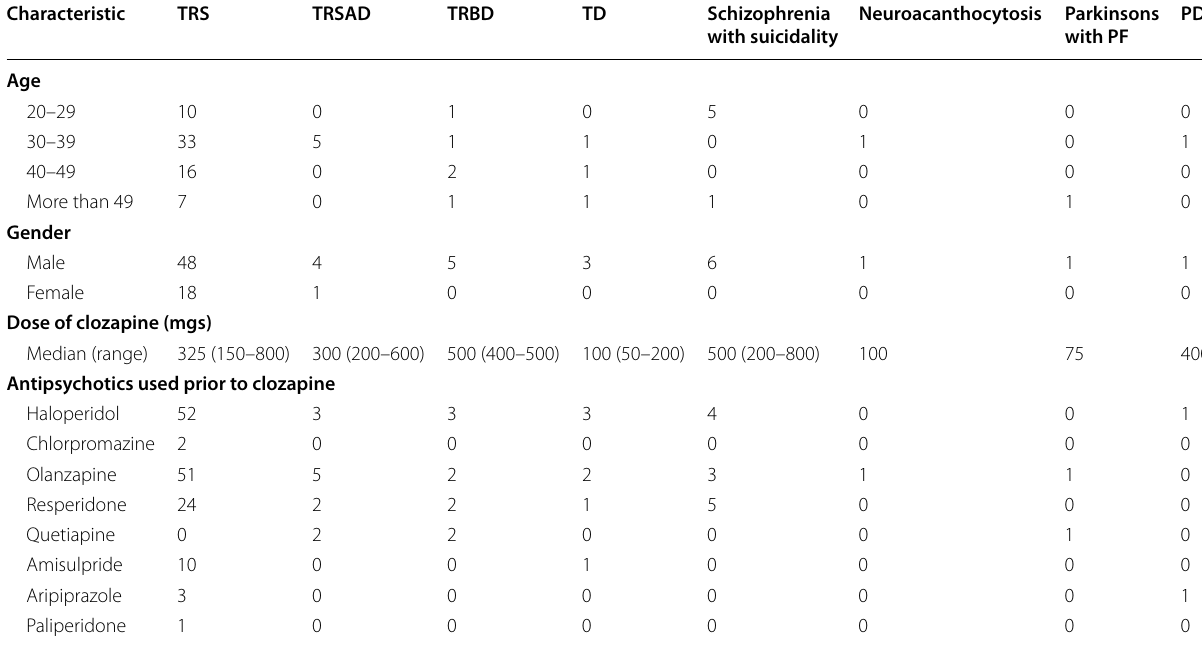
Table 3 The descriptive analysis as per the diagnosis of patients on clozapine